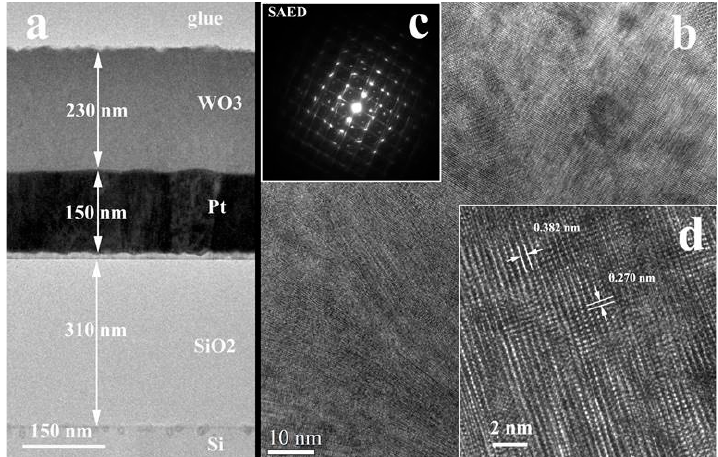
Figure 2. XTEM images of the WO 3 film deposited on Pt/SiO 2 /Si substrate using the 193 nm laser radiation: ( a )—Low magnification TEM image of the sample cross ‐ section; ( b )—poor ‐ crystallized columnar grain structure; image collected in the middle of the film thickness; ( c )—SAED of the columnar grain structure; ( d )—HRTEM detail of the WO 3 columnar grain structure.